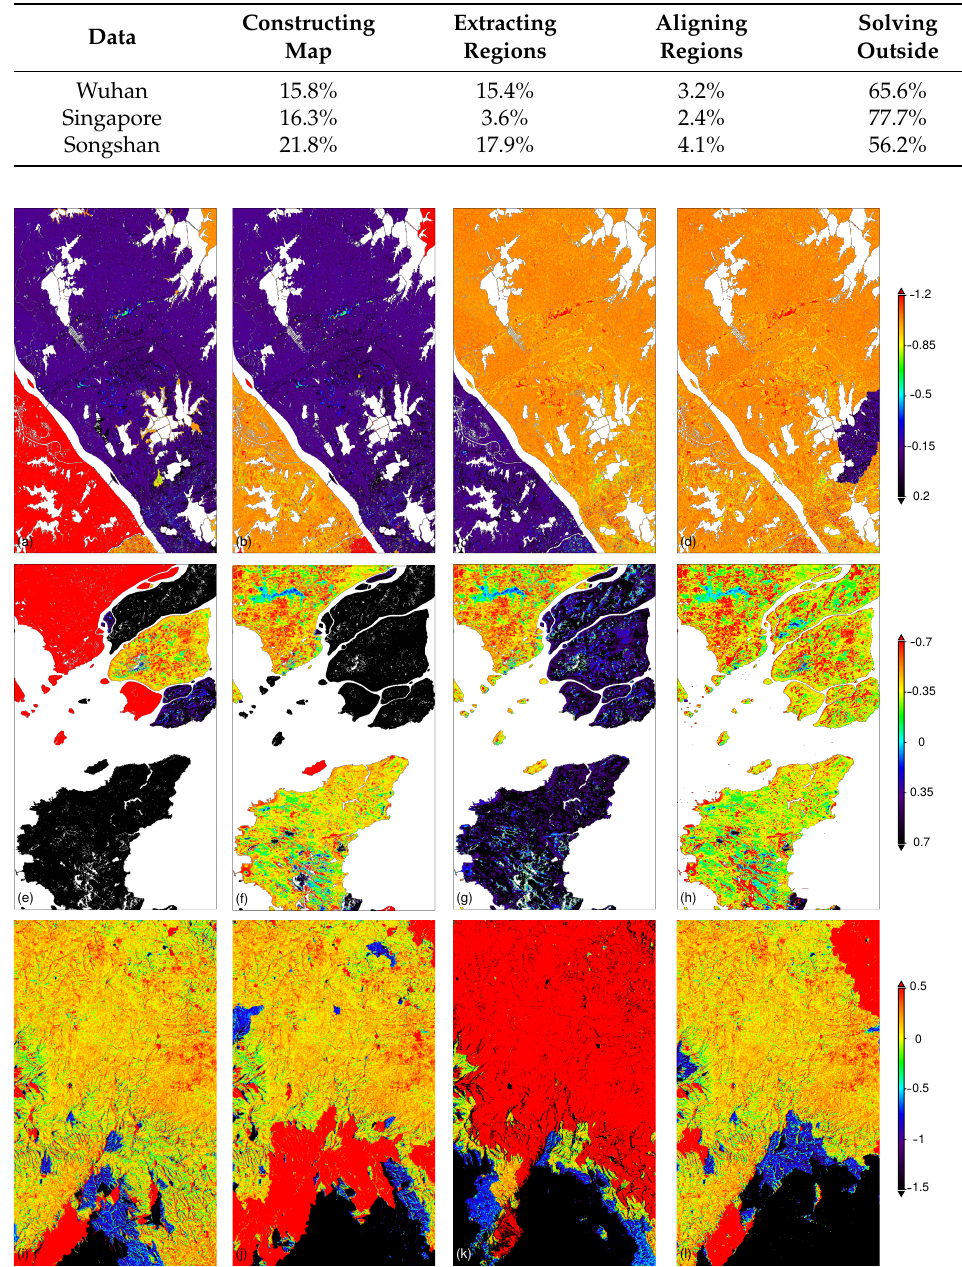
Figure 15. The wrapped phase for the experimental data of Wuhan ( a – d ), Singapore ( e – h ), and Songshan ( i – l ) from the SNAPHU, region growing, GAMMA, and PHASS PU